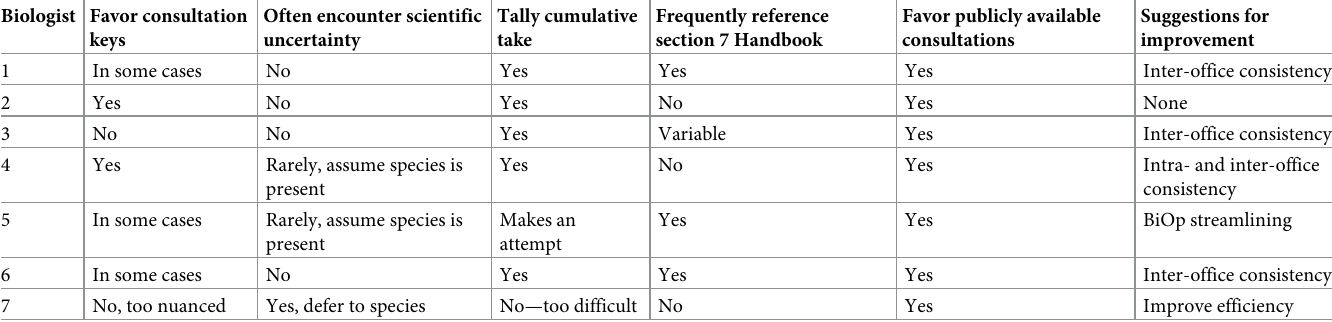
Table 5. Responses to a selected sample of consultation process questions asked of FWS/NMFS biologists. Biologist Favor consultation